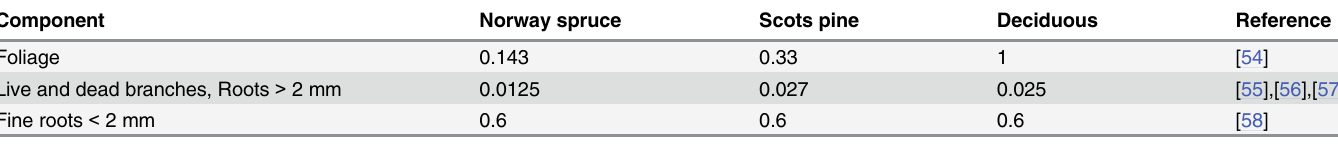
Table 1. Annual turnover rates (year -1 ) applied for the estimation of tree litter input.